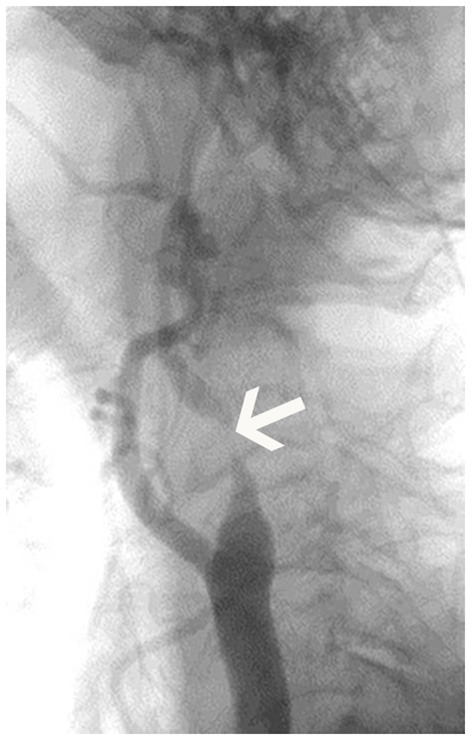
Digital subtraction angiography (DSA) imaging of patient. The figure displayed the severe carotid stenosis (arrow) in the left internal carotid artery.